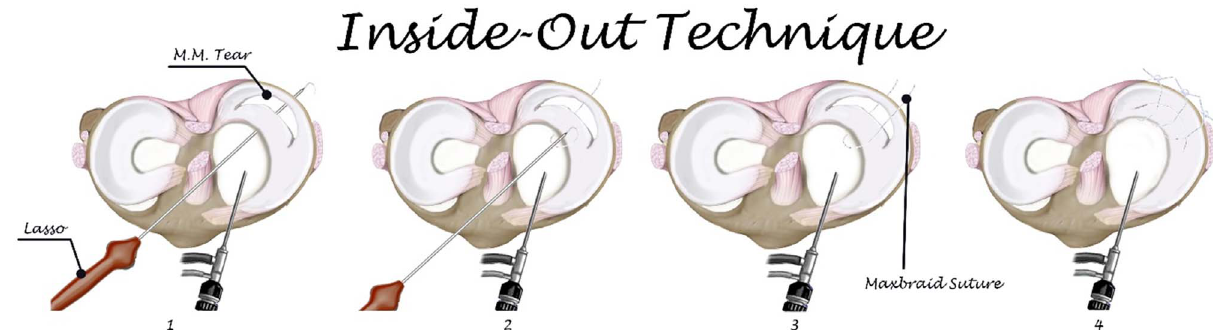
Figure 1. Steps of Inside-out technique.